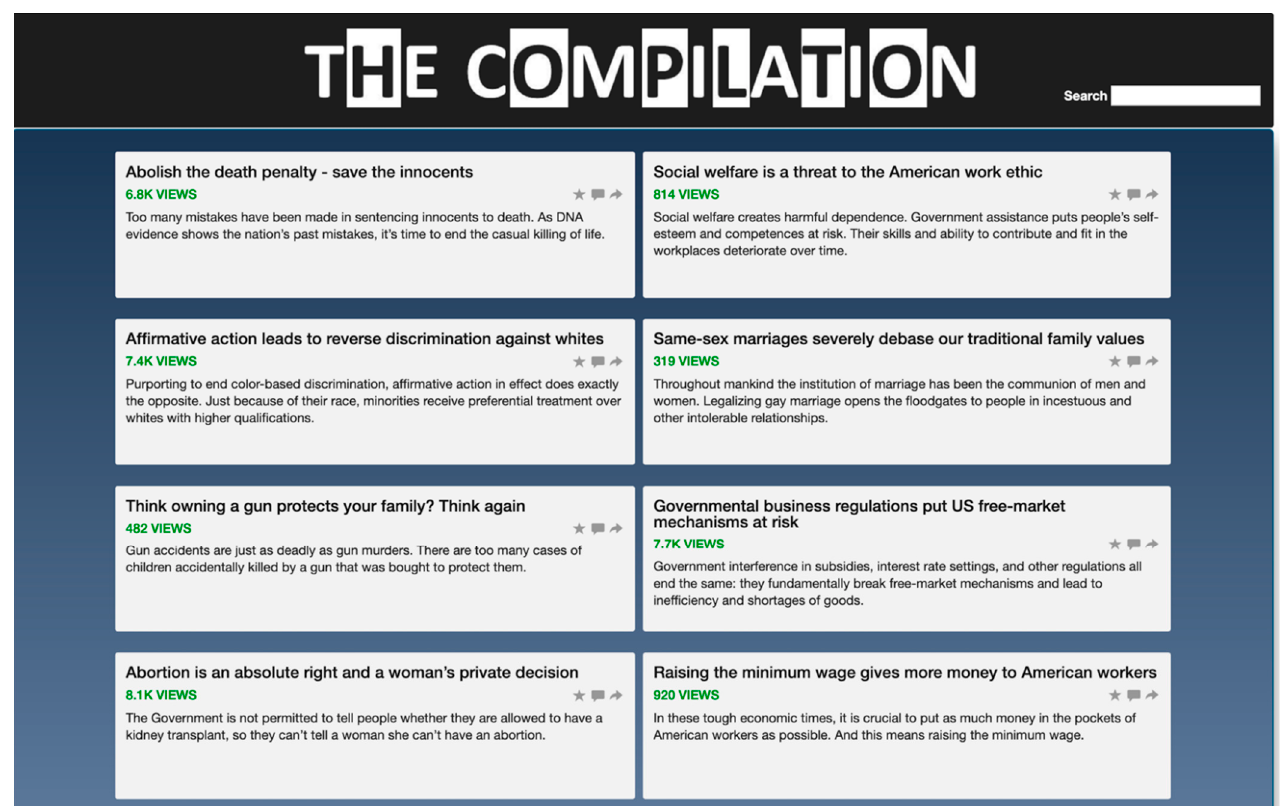
Figure 1. Screenshot of Selective Exposure Website (Computer Condition).